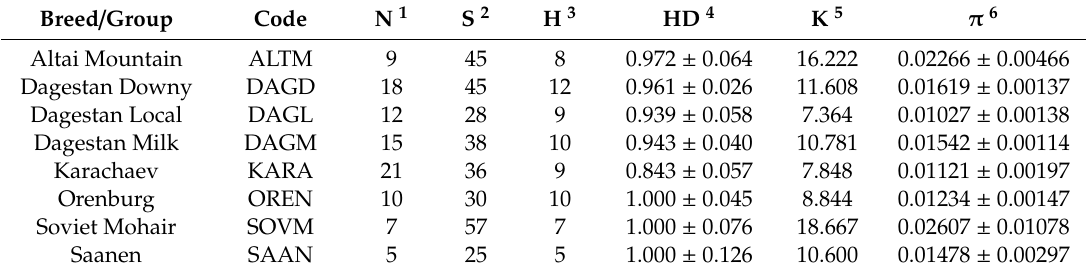
Table 1. Genetic diversity of mitochondrial DNA (mtDNA) in the goats reared in Russia. Breed / Group Code N 1